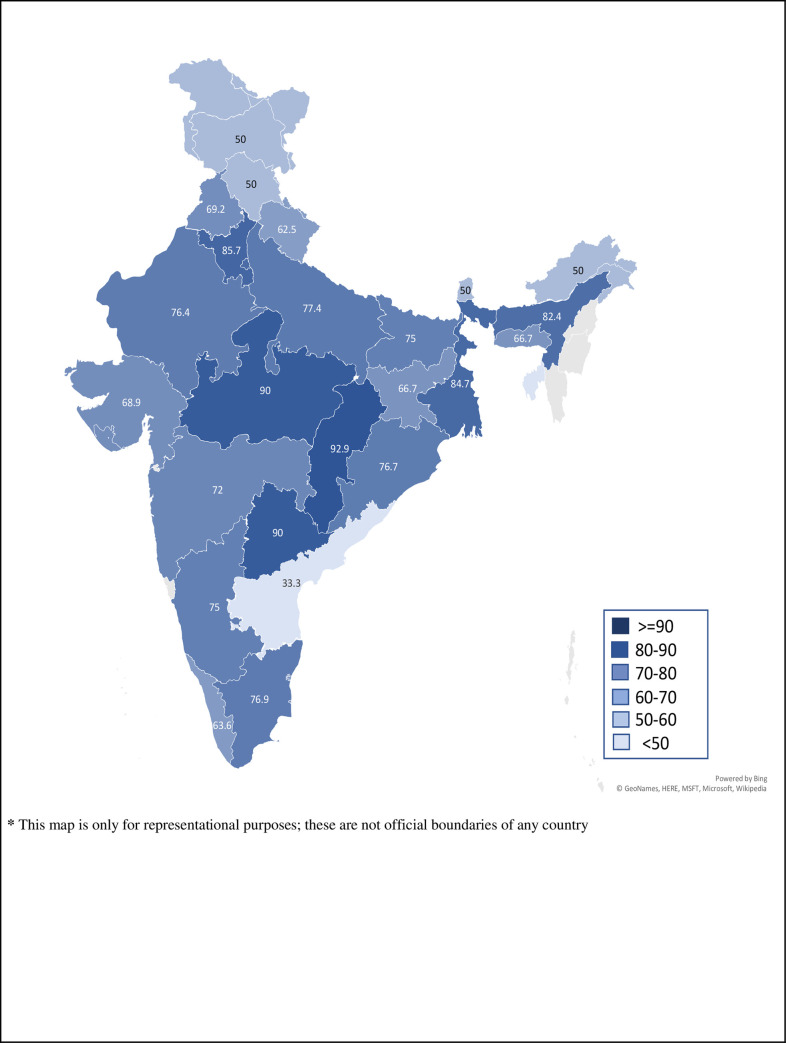
State-wise distribution of study participants who had ever-faced workplace violence.[(Total number of participants who faced workplace violence in the state / Total number of participants who responded from that state)*100].